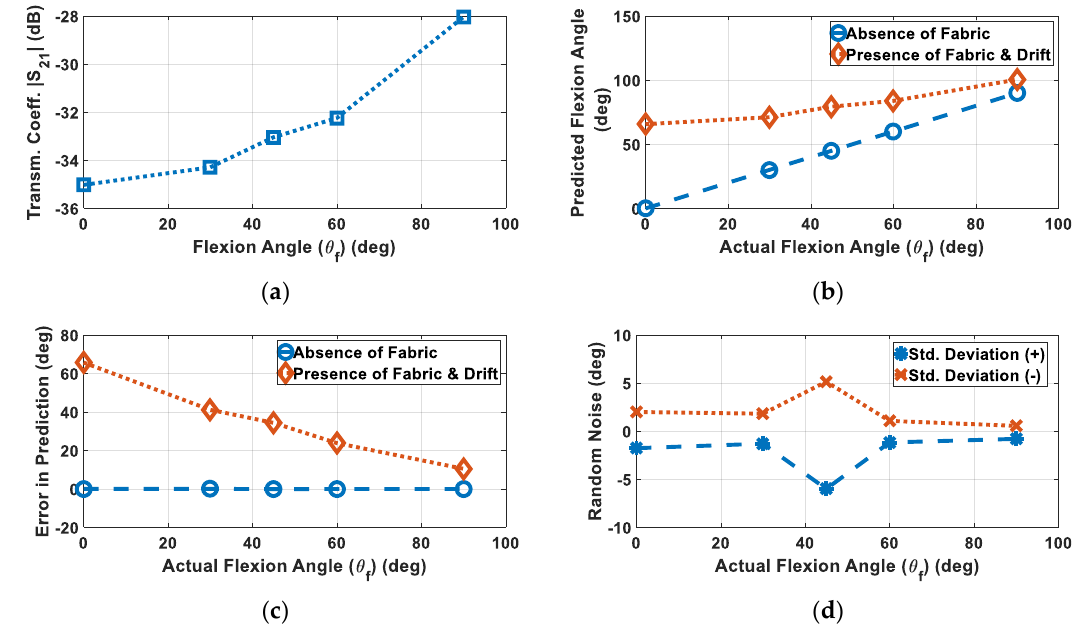
Figure 7. ( a ) Noisy |S 21 | data (due to fabric drift) obtained using simulation set-up of Figure 6a. ( b ) Predicted θ f with respect to actual θ f obtained via calibration plot of Figure 6b, both in the absence and presence of fabric drift, along with ( c ) respective error in predicted θ f , for both cases. High error outlines the importance of incorporating fabric drift model in the wearable sensors’ calibration. ( d ) Random noise caused during fabric drift vs. θ f , highlights the importance of specifying noise tolerance for wearable sensors.